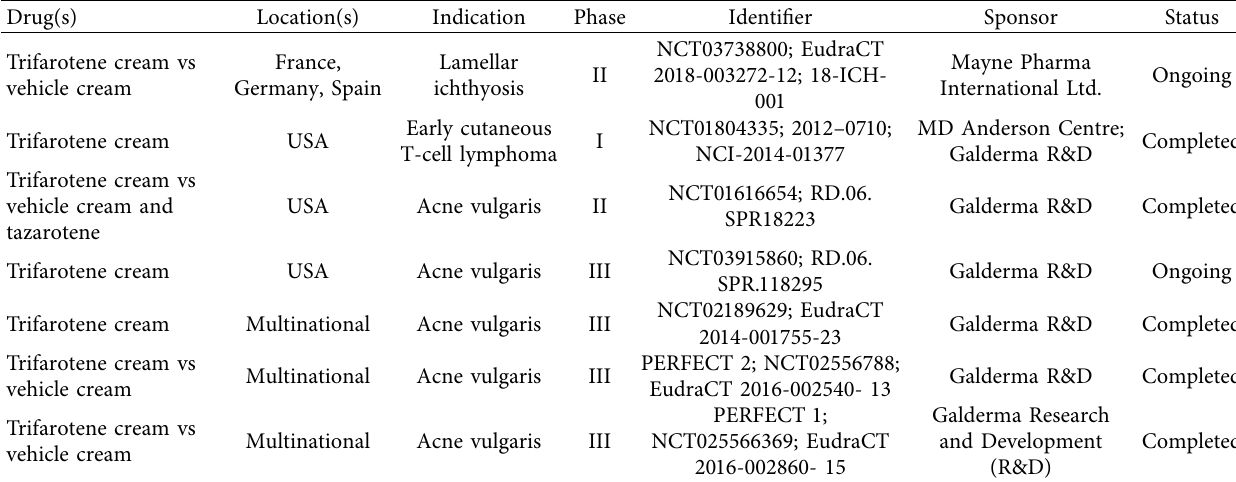
Table 1: Important clinical trials of